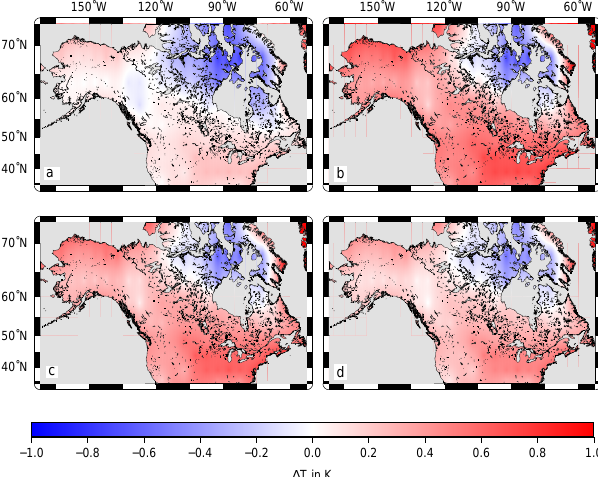
Figure 11. Spatial distribution of differences in estimated GSTH i.e. blue areas are those where reconstructions are colder than the true solution, and red areas are those where with and without the influence of the LGC; i.e., the blue areas are they are warmer. Shown are the GST differences over the time intervals from (a) 0–150 years BP, (b) 150– those where reconstructions are colder than the true solution, and 300yearsBP,(c)300–450yearsBP,and(d)450–600yearsBP. red areas are those where they are warmer. Shown are the GST dif- ferences over the time intervals from (a) 0 to 150yrBP, (b) 150 to that the purely conductive air-ground coupling assumption in our forward model does not translate 395 300yrBP, (c) 300 to 450yrBP, and (d) 450 to 600yrBP. well into a one-dimensional conductive subsurface model. Thus, according to our experimental estimates of the effect of the LGC on the thermal regime of the shallow subsurface from the MUN-GSM, the global temperature reconstructions (Pollack et al., 1996; Harris and Chapman, 2001; Beltrami and Bourlon, 2004) will not be largely affected. trami and Bourlon, 2004), the maximum temperature change The effect of the LGC, on our synthetic GSTH example, appears to be small for the last 150 years. 400 in the subsurface temperature profile should be on the order Between1500to1850CE,itseffectamountstoasuppressionofthewarming,thusthemostrelevant of 50 mK in a decade, and the detection of such changes is effect may be a larger magnitude of warming for the recovery from the Little Ice Age (LIA) than already what BTPs analyses have already estimated. This effect nevertheless would be expected to have the largestinfluenceononlyafractionofBTPsinthenorthernlatitudes. Inotherwords,thoseareasthat have been under the ice sheet, and those which have the subsurface signature of the LIA. 405 Our results present for the first time, an estimation of the energy contribution to the ground sub- surface from the LGC. The spatial variability of the subsurface energy remaining from the LGC are